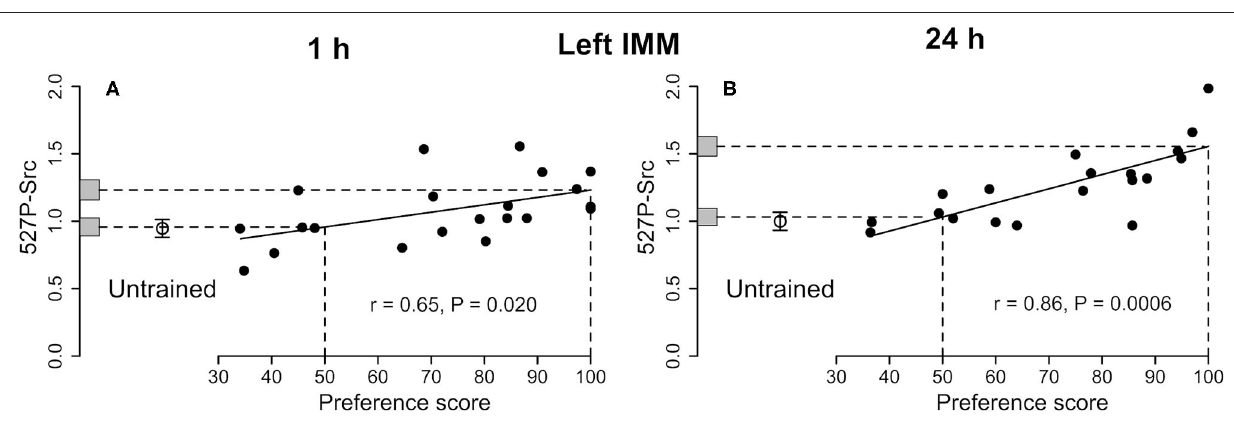
FIGURE 3 | Left IMM. Standardized relative amount of 527P-Src plotted against preference score 1h (A) and 24h (B) after the end of training. Conventions otherwise as for Figure 1 . For both times the correlations are significant. In each plot, the mean value for untrained chicks is significantly lower than the intercept at preference score 100 and not significantly different from the intercept at preference score